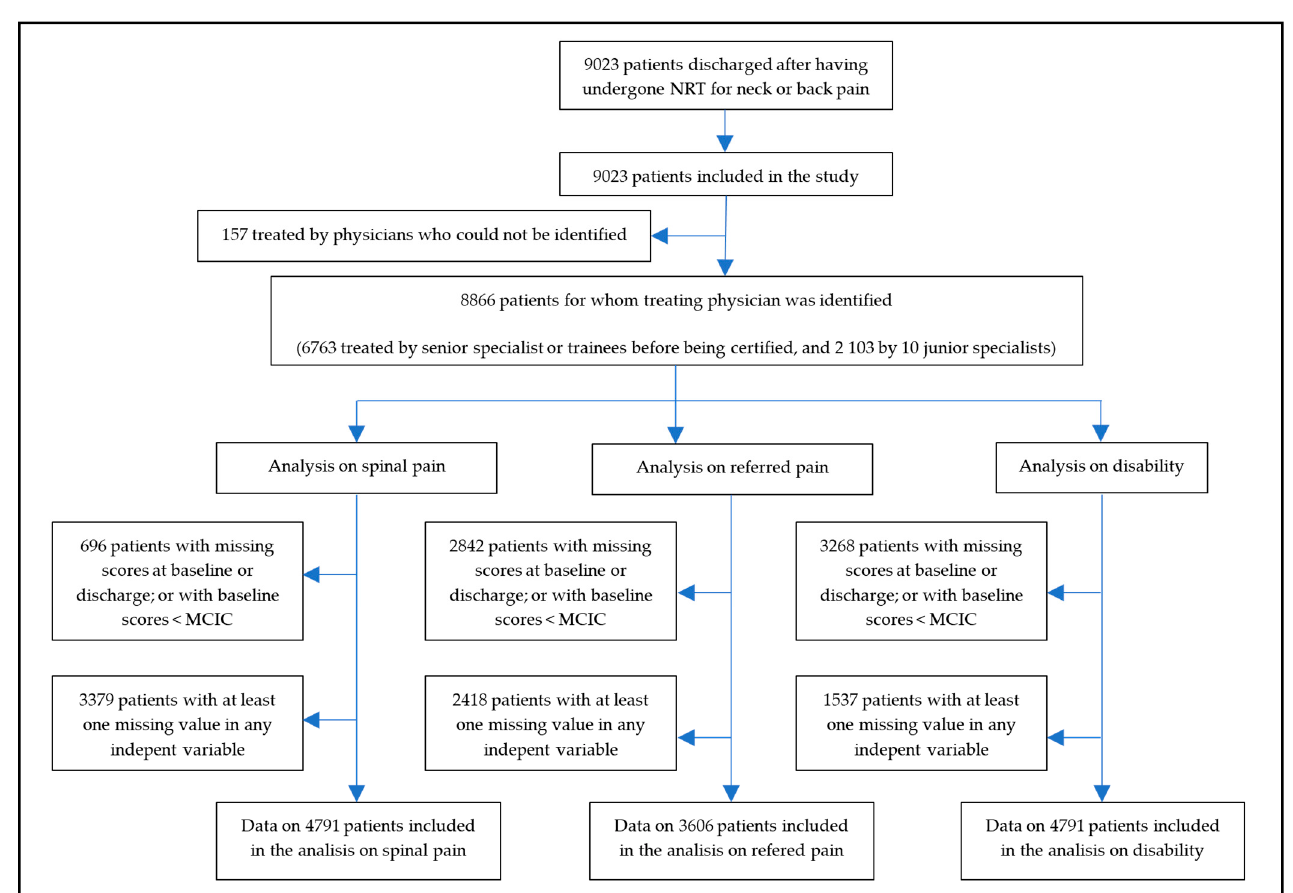
Figure 2. Flow chart of the study.